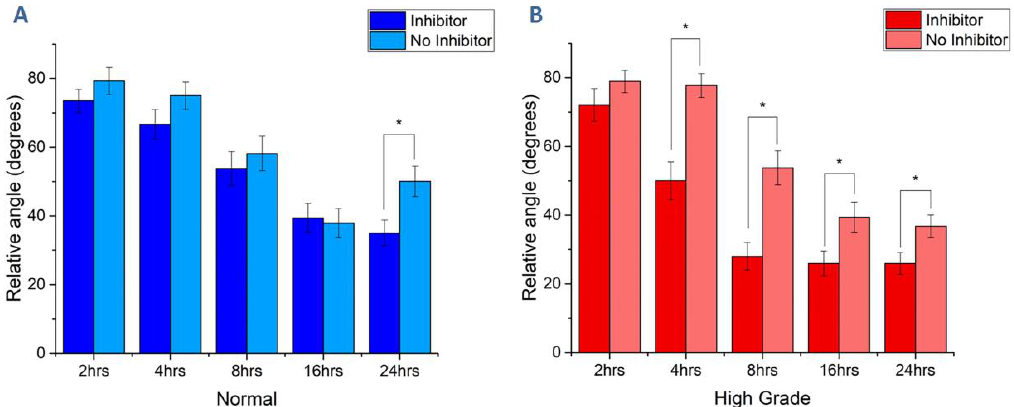
Figure 9. OVCA433 cell alignment on normal ( A ) and high-grade ( B ) stromal models in response to ROCK inhibition. Lower angles correspond to higher alignment, and significant differences were found at all time points after 2 h on the high-grade matrix. (* p <